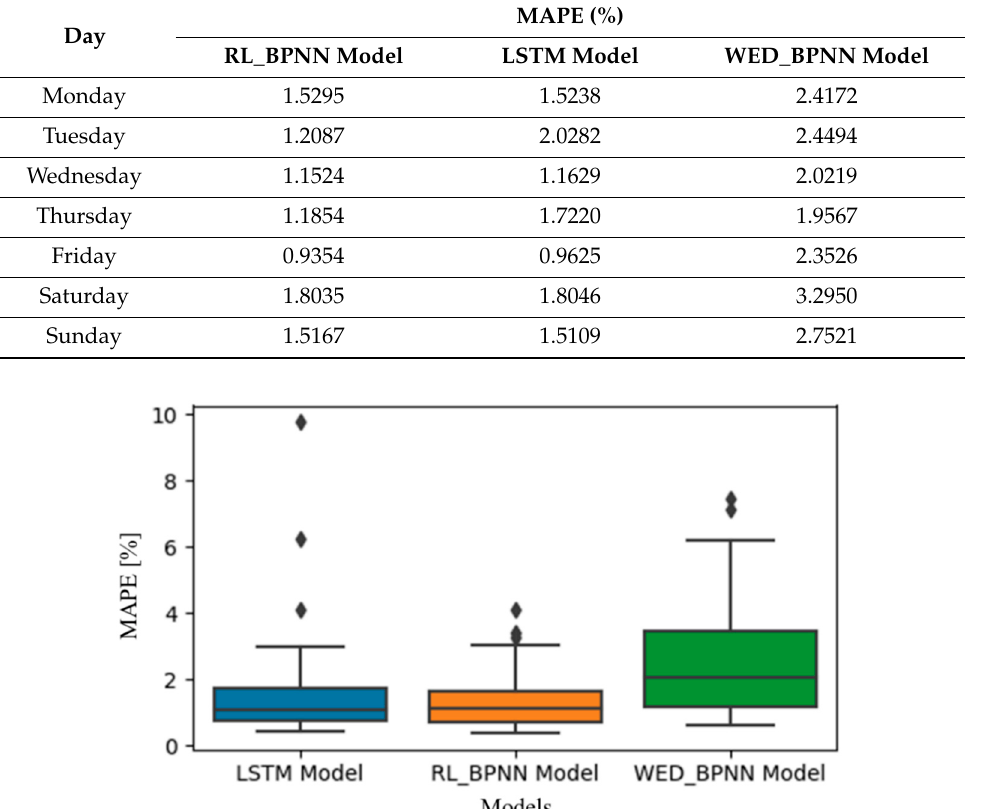
Table 7. MAPE of the models by day of week.